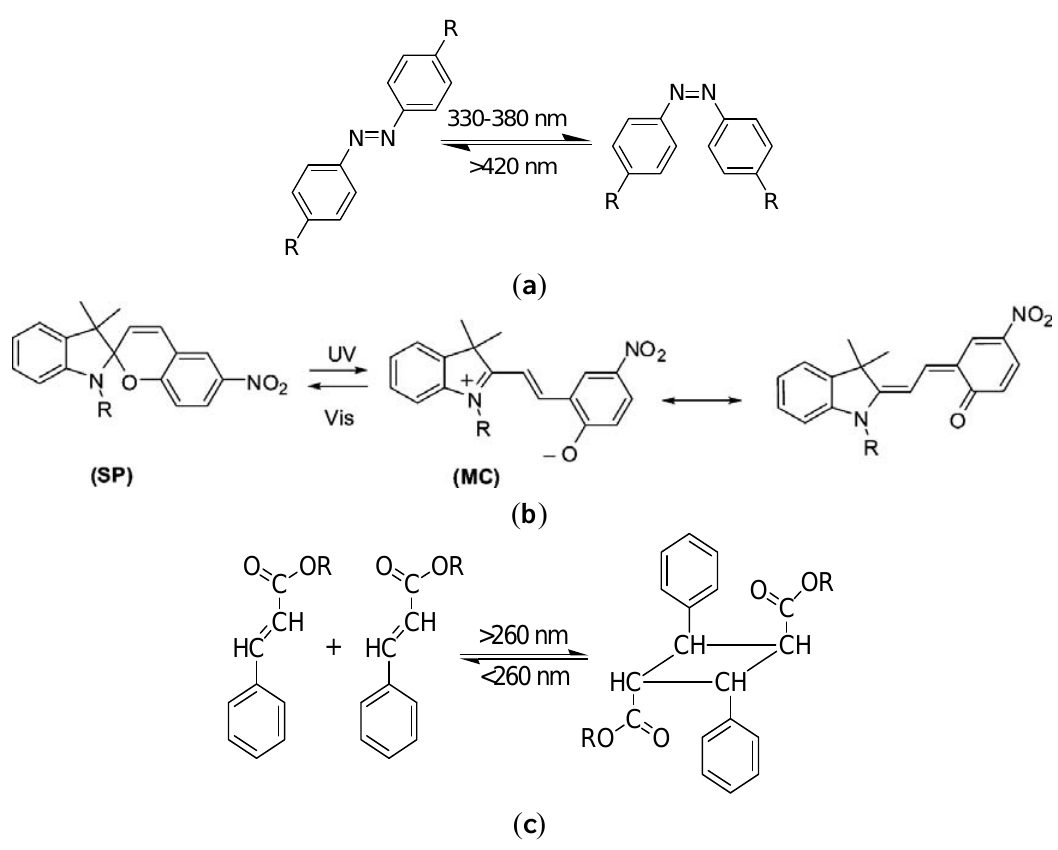
Figure 4. Schematic illustrations of reversible photoisomerization. ( a ) photoisomerization of azobenzene groups; ( b ) isomeric molecular structure of a spiropyran irradiated with light, spiropyran (left), merocyanine (center), and quinoidal canonical form (right); ( c ) photodimerization of the cinnamic acid group. Reprinted (adapted) with permission from